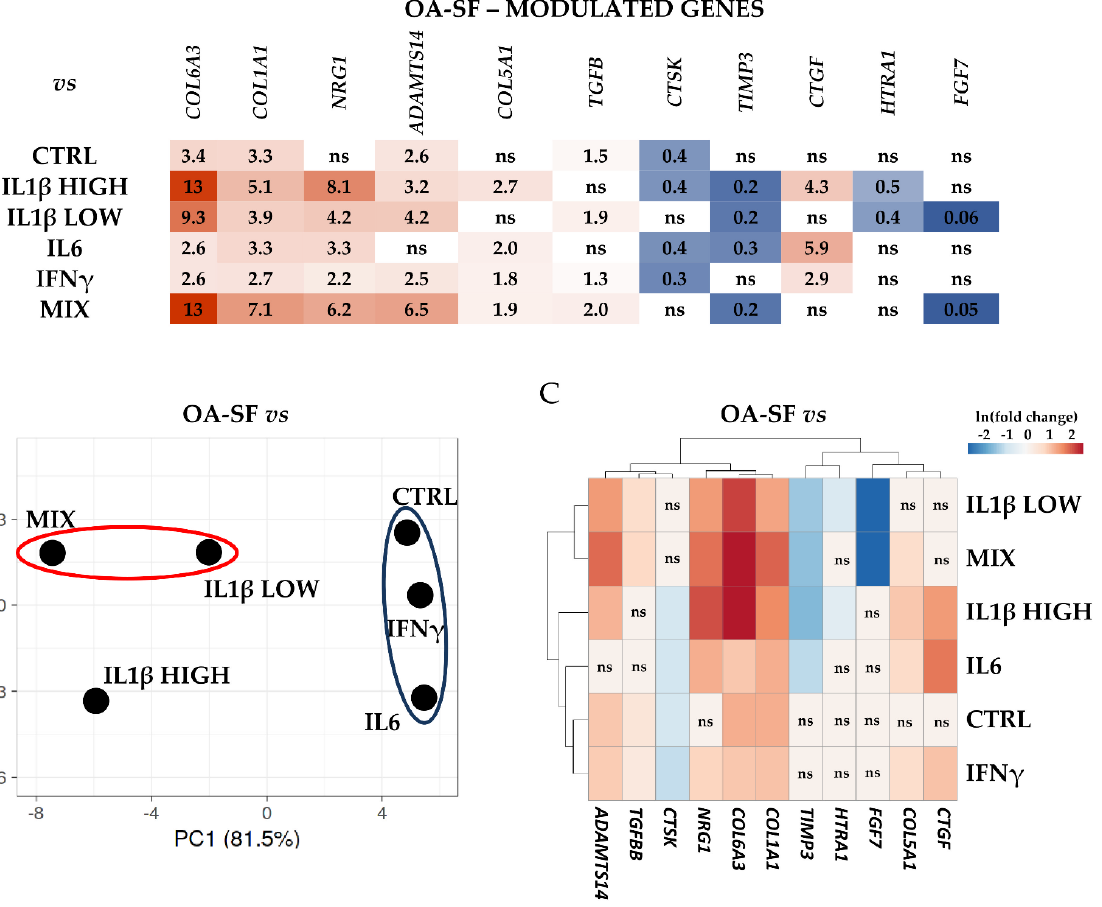
Figure 5. Differential expression of OA-SF-specific genes with respect to control (CTRL) and the other stress treatments (abbreviations as in Figure 2) in the three HCH donors. ( A ) Red shades indicate higher expression ratios and blue shades indicate lower expression ratios of OA-SF with respect to the other conditions. Color key indicates the intensity associated with expression ratios. Mean values are shown. ns = not statistically significant (p-value > 0.05). p-value for each shown ratio can be found in Supplementary Table S4. ( B ) PCA based on the expression ratios of OA-SF with respect to the other conditions. ( C ) Heatmap based on the ln transformed expression ratios of OA-SF with respect to the other conditions. Red shades indicate higher expression ratios and blue shades indi- cate lower expression ratios. Color key indicates the intensity associated with expression ratios. ns = not statistically significant (p-value > 0.05).